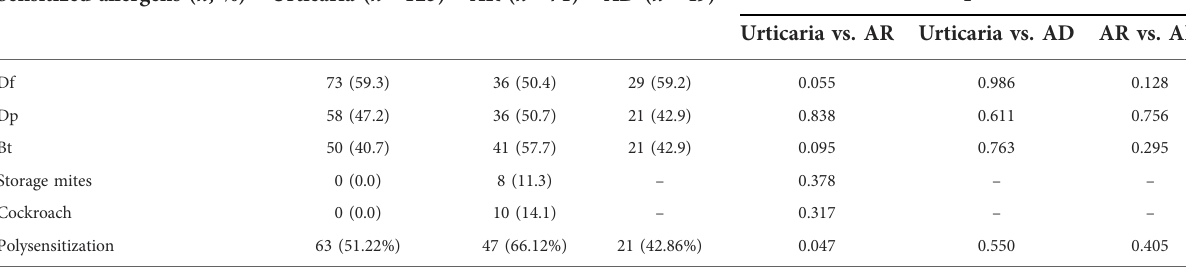
TABLE 3 Pro fi le of allergens screened in patients with allergic diseases Fisher ’ s exact tests. Sensitized allergens ( n , %) Urticaria ( n = 123) AR ( n = 71) AD ( n = 49)